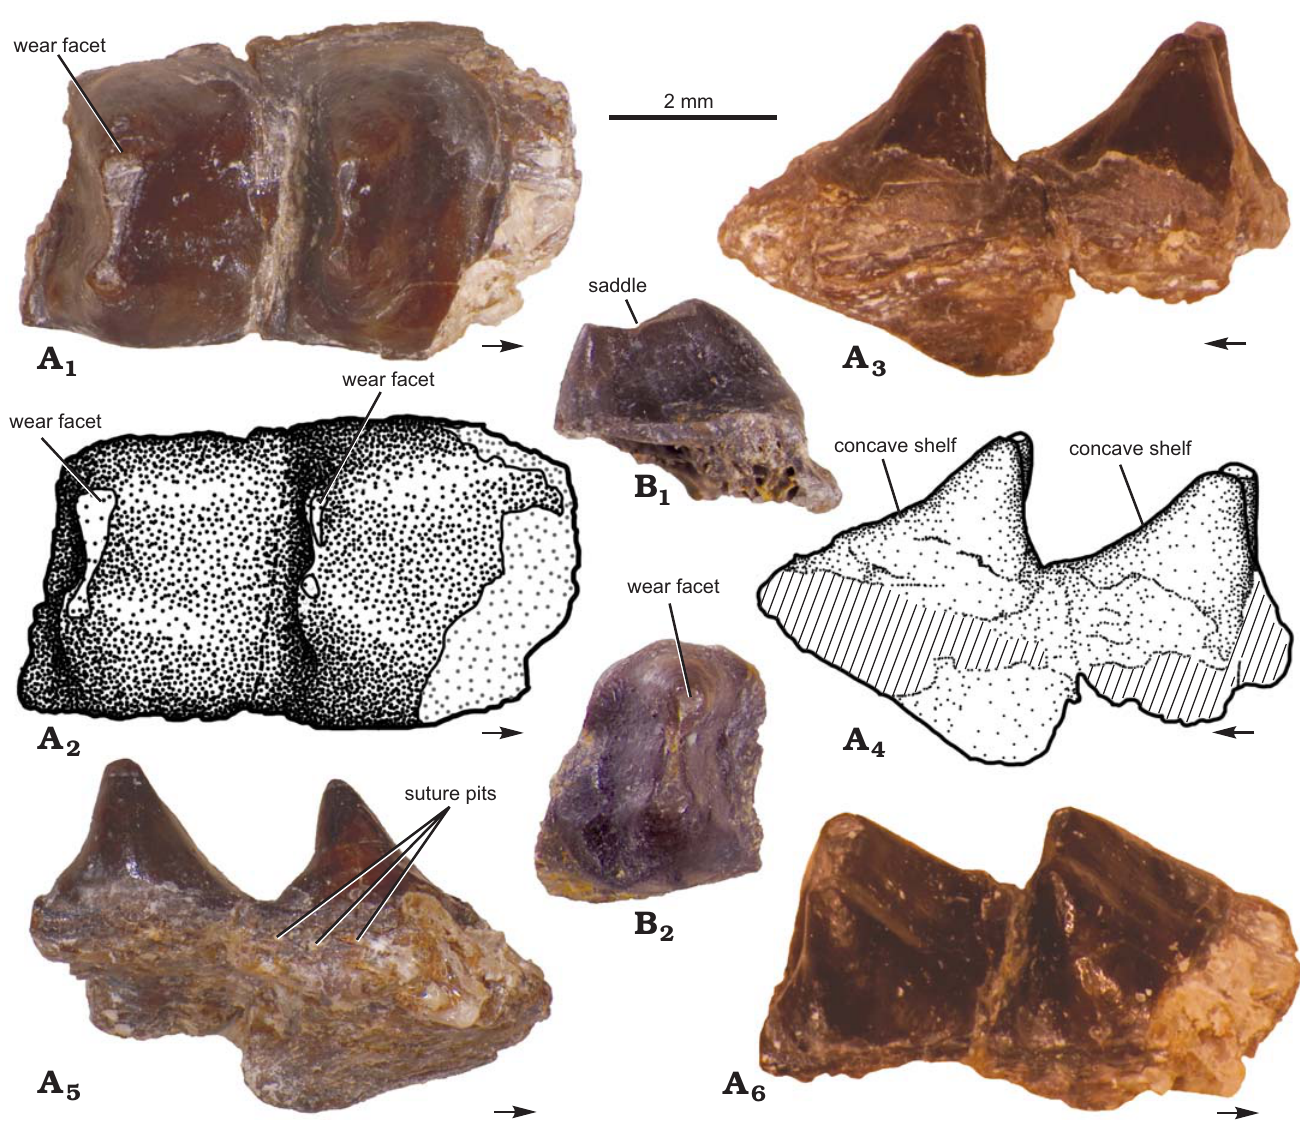
Fig. 3. Diapsid Palacrodon sp. from Norian, Placerias Quarry, St. John’s, USA. A . MNA 3684, fragment of marginal dentition with two complete teeth in occlusal (A 1 , A 2 ), labial (A 3 , A 4 ), lingual (A 5 ), and oblique (A 6 ) views. B . MNA V11247, isolated tooth in occlusal (B 1 ) and distal (B 2 ) views. Arrows point in anterior direction. Photographs (A 1 , A 3 , A 5 , A 6 , B), explanatory drawings (A 2 , A 4